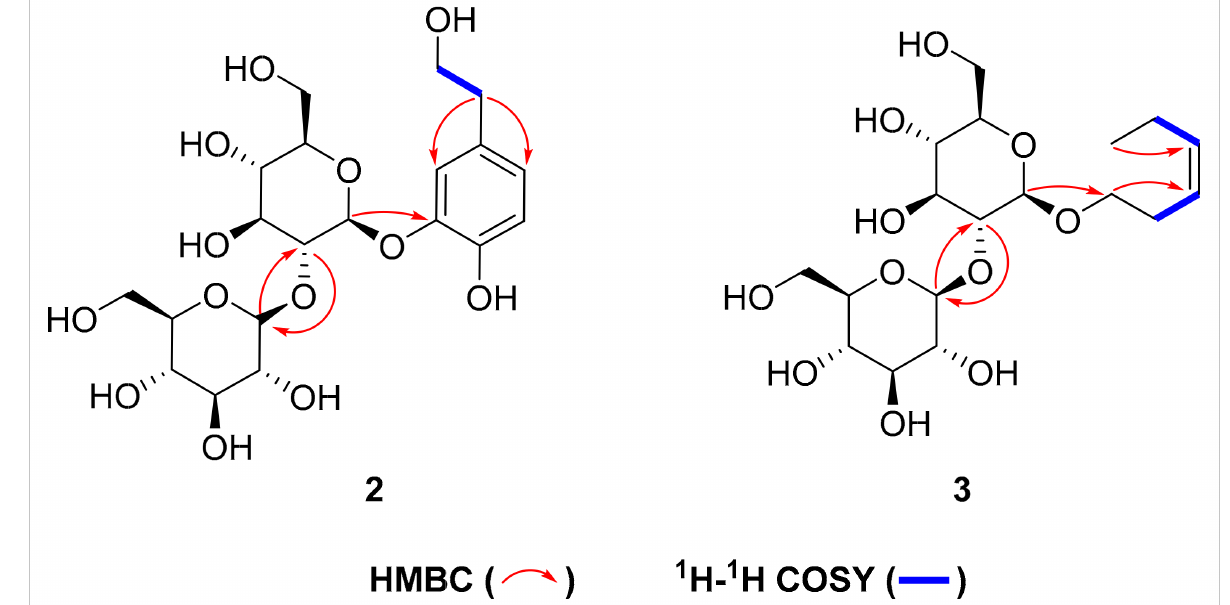
Figure 4. Selected HMBC and 1 H- 1 H COSY correlations of 2 and 3